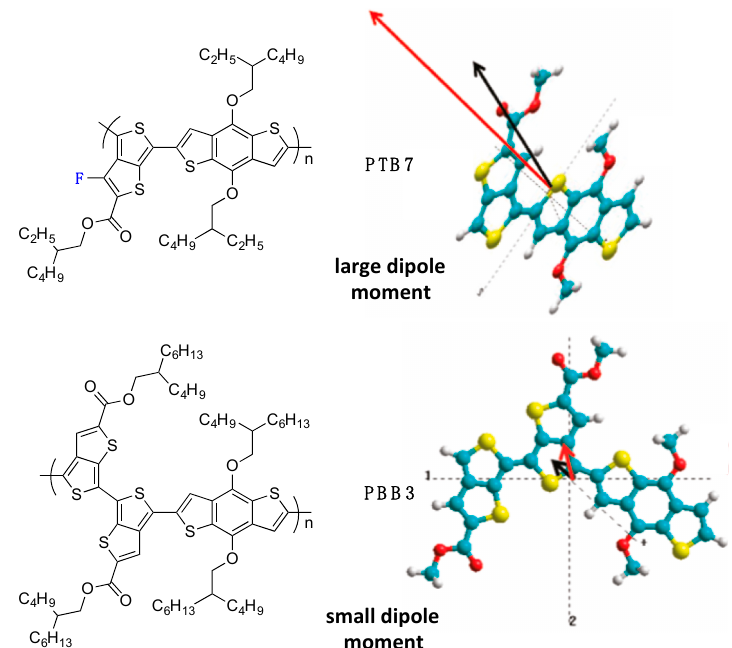
Figure 15. Chemical structure of the PTB7 and PBB3 copolymer ( left ). Dipole moment calculations for PBB3 and PTB7 ( right ). The ground (black arrow) and excited (red arrow) state dipole moments of the PBB and PTB monomer units are drawn to scale. The axes (dotted lines) represent the center of mass axes in the x, y and z directions. The vector of the dipole shows the direction of electron flow in these directions (adapted with permission from [57]; Copyright 2011 American Chemical Society).